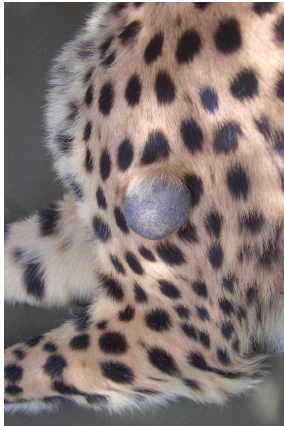
Figure 1: Exophytic solid basal cell tumor of a Namibian cheetah located on the left shoulder.